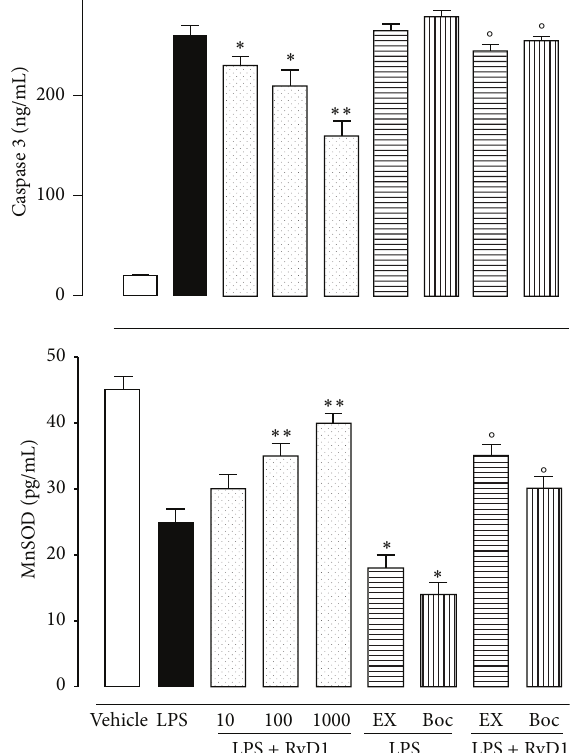
Figure 7: MnSOD and caspase 3 levels in ocular tissues of LPS-treated rats after RvD1 (10, 100, 1000ng/kg), EX-527, and Boc2. Results are the mean ± S.E.M. of 6 observations per group. Significant differences with the LPS are shown as ∗ 𝑃 < 0.05 and ∗∗ 𝑃 < 0.01 , while differences versus RvD1 1000 ng/kg are shown as ∘ 𝑃 < 0.01 . EX = EX527; Boc = Boc2; RvD1 = resolvin